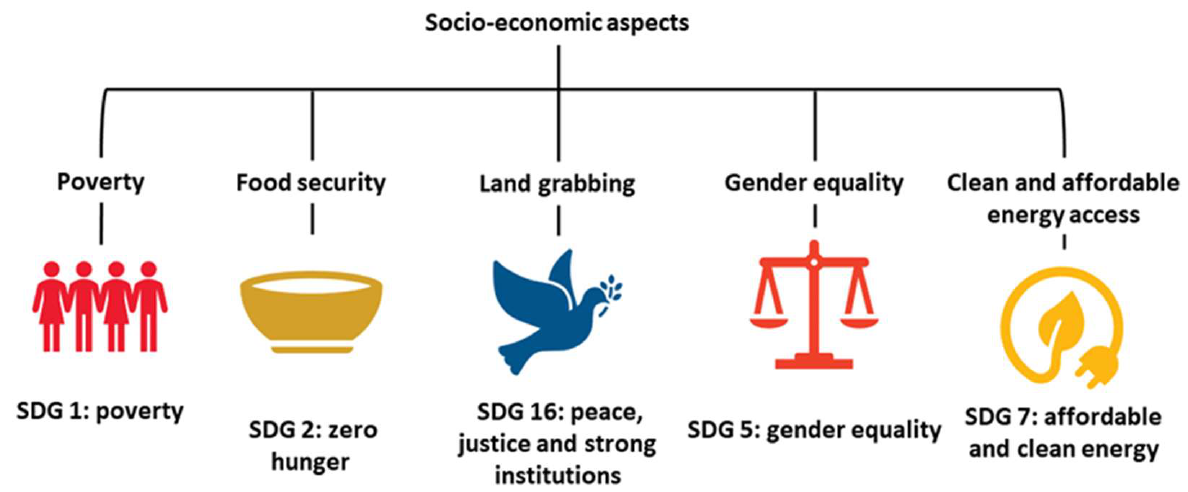
Figure 3. An overview of the socio-economic aspects and the corresponding Sustainable Development Goals (SDGs) included in the following section.